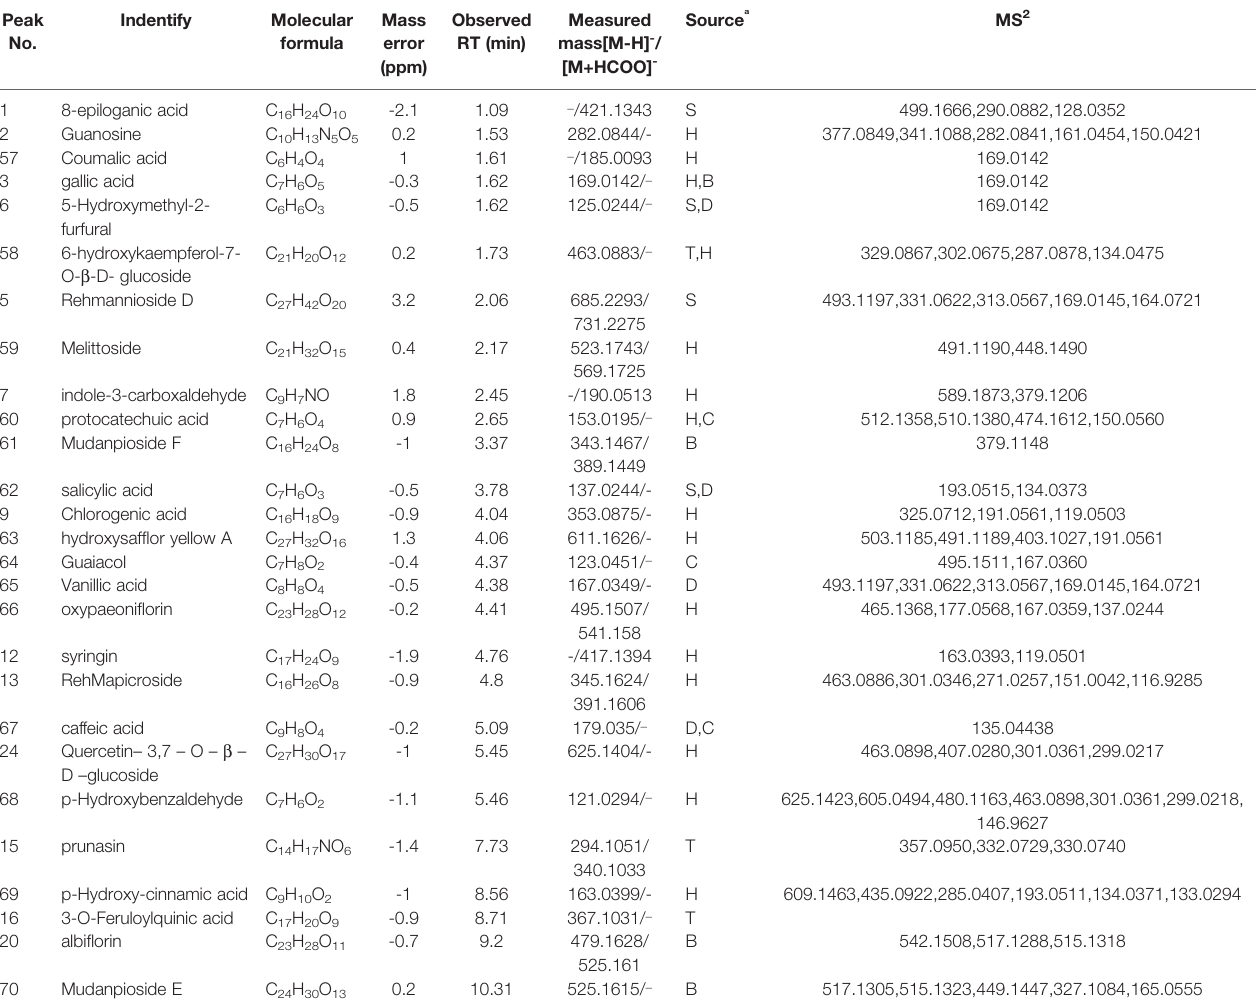
TABLE 2 | Compounds identi fi ed in THSWD by UPLC-Q-TOF-MS in negative ion mode. Peak